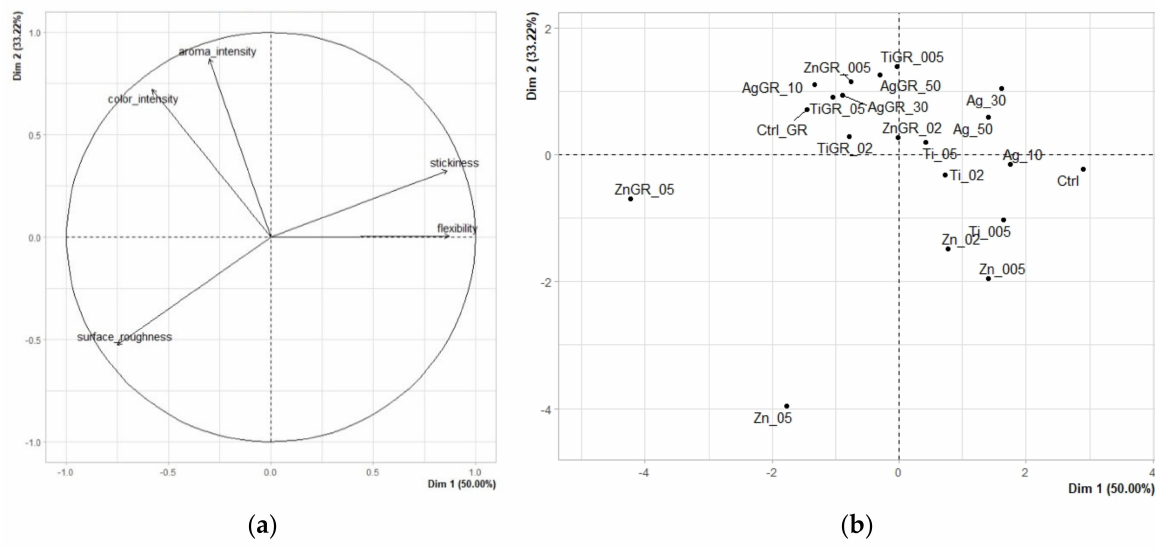
Figure 1. The PCA results of quantitative descriptive analysis of edible coatings: ( a ) Variables factor map. ( b ) Score plot for the mean